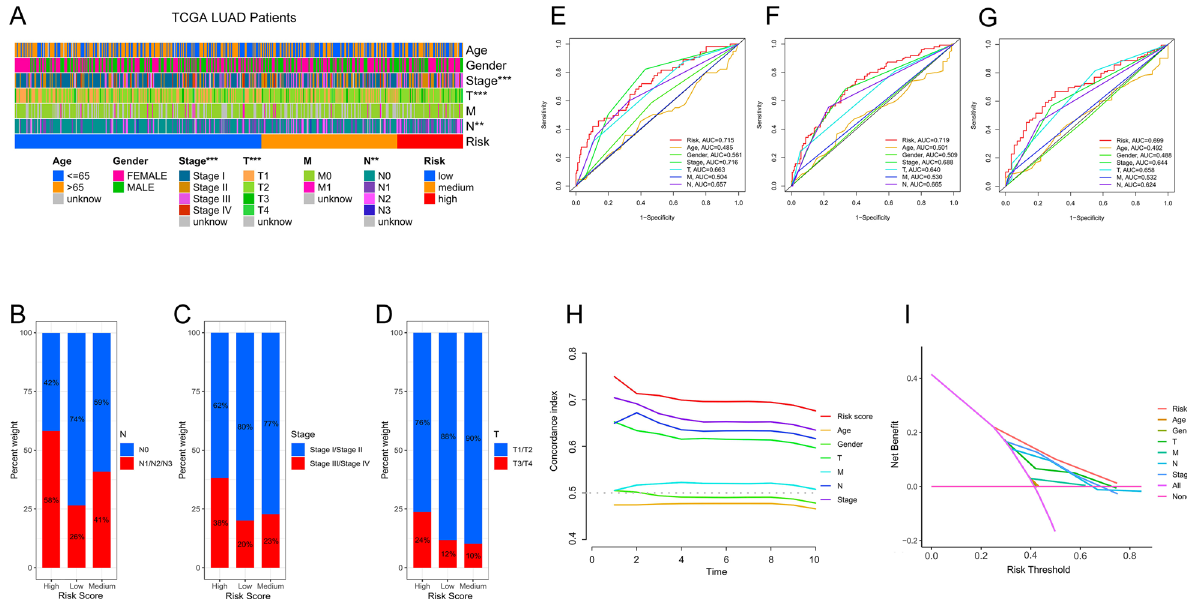
Figure 3. Correlations analysis between the risk signature and clinical features using R software. ( A ) The heatmap and clinical features of three risk groups. ( B – D ) Bar plot of correlation between risk score and N ( B ), Stage ( C ), T ( D ) of LUAD. ( E – G ) ROC curves for 1-year ( E ), 3-year ( F ), 5-year ( G ) survival prediction and clinical characteristics. ( H ) Time-related concordance index of risk score and clinical characteristics. ( I ) The decision curve analysis of risk score and clinical characteristics. * p -value < 0.05, ** p -value < 0.01, *** p -value <